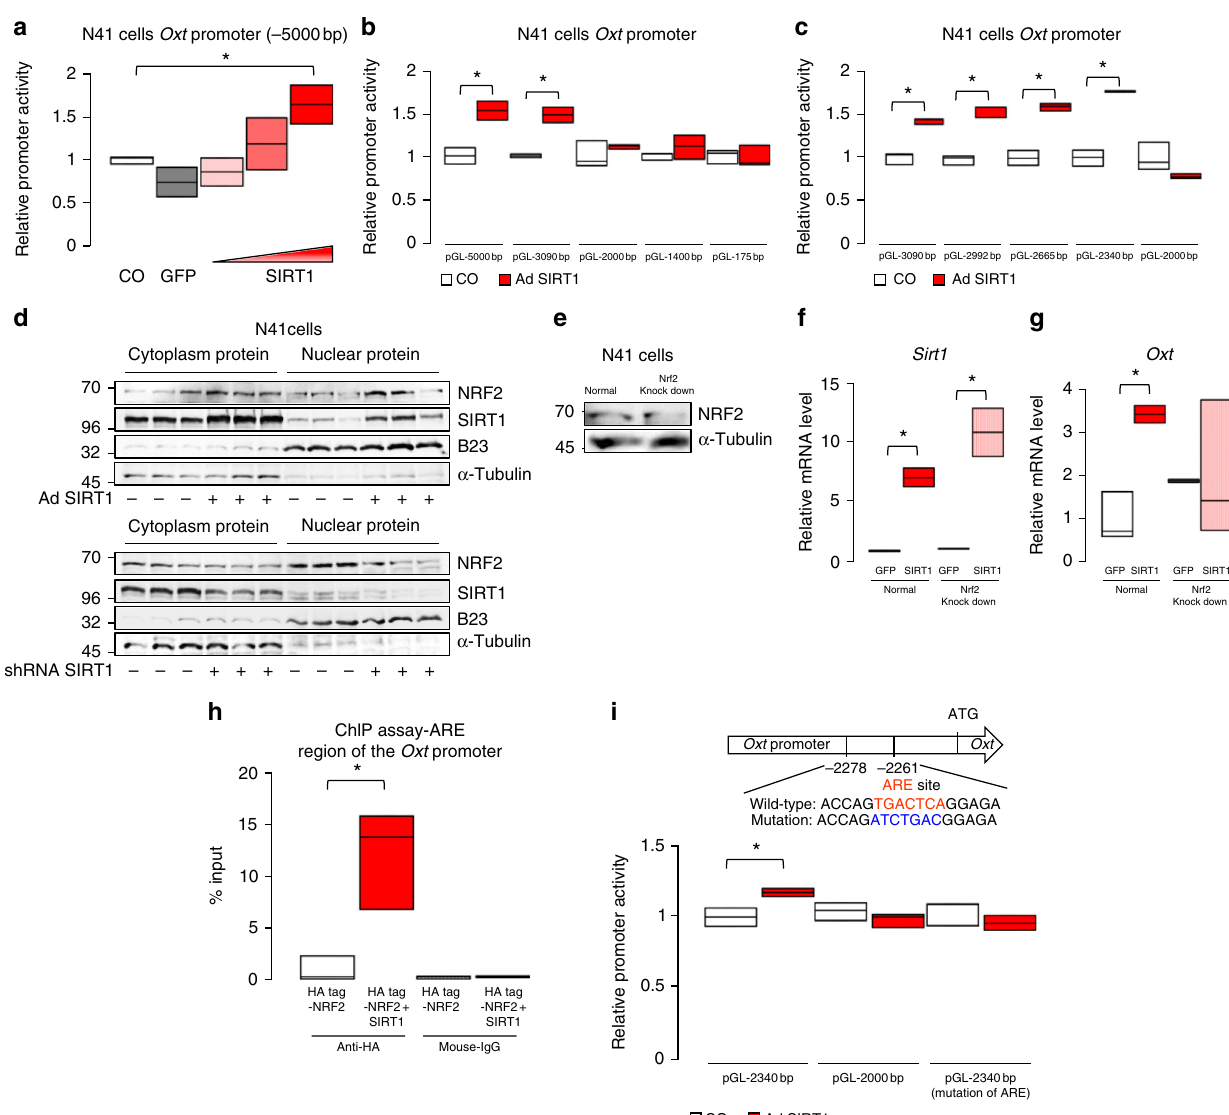
Fig. 8 SIRT1 regulates expression of Oxt through NRF2. a – c Luciferase assays of Oxt promoters of various lengths in N41 cells. Luciferase activity was measured in response to adenoviral overexpression of Sirt1 (ad-Sirt1), the control virus (GFP) and uninfected cells (co, normalized to 1). Sirt1 activation of full-length ( − 5000) ( a ) and truncated ( b , c ) Oxt promoters ( n = 3 per each group). d The effects of overexpressing (upper panels) or silencing (lower panels) Sirt1 expression in N41 cells on nuclear NRF2 protein levels. Immunoblots of nuclear and cytoplasmic fractions probed for NRF2, SIRT1, B23 (nuclear marker) and α -tubulin (cytoplasm marker) ( n = 3 per group). e – g Effect of Nrf2 knockdown on SIRT1-induced Oxt expression. After lentiviral knockdown of Nrf2 in N41 cells ( e ), Sirt1 expression levels were manipulated with adenoviral overexpression ( f ), and Oxt expression was measured ( g ) ( n = 4 per group). h ChIP performed on HA-tagged NRF2, FLAG-tagged SIRT1 or pCMV5 (empty)-transfected N41 cells using HA tag or mouse IgG antibody. ChIP DNA was subjected to quantitative PCR using primers speci fi c for the ARE region in the Oxt promoter. Data are presented relative to input ( n = 3 per group). i Activity of the − 2430-bp promoter with and without mutations in the ARE region ( n = 3 per group). Data are shown as box and whisker plots (centre line, median; box limits, upper and lower quartiles; whiskers, the minimum and maximum value of a data set). * p < 0.05. Data in a – i were replicated twice in the laboratory. See also Supplementary Fig.